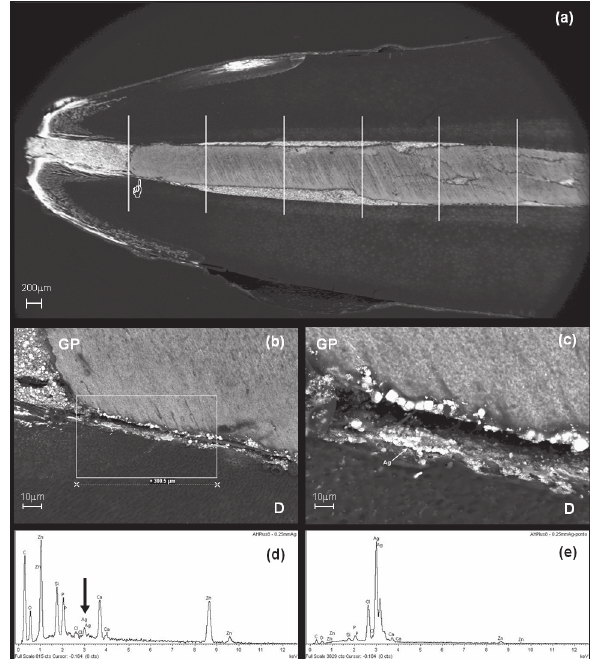
Figure 1- Scanning electron microscopy (SEM) micrographs using back scattered electrons (BSE) mode and corresponding energy dispersive spectroscopy (EDS) spectrum of AgNO leakage: (a) - The apical 5 mm of the root canal filling divided 3 into 1 mm-regions. Pointer at the detected metallic silver; (b) – area (300 m m 2 ) scanned for the existence of silver and respective EDS spectrum (arrow) and (c) - in detail, punctual EDS confirmation of its exact location.